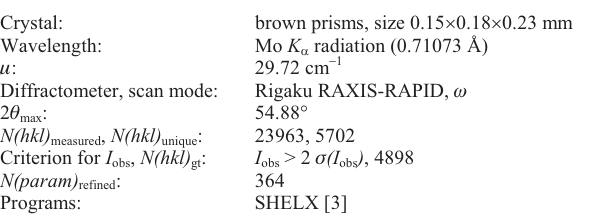
Table 1. Data collection and handling.